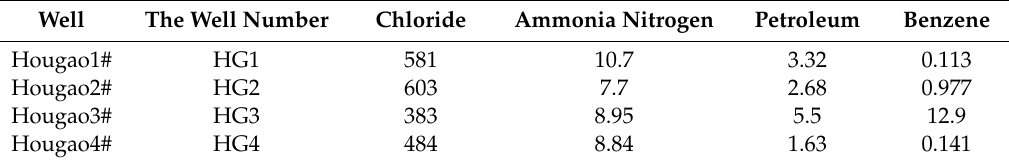
Table 1. Water quality monitoring data of Hougao’s four wells in March 2016 (mg / L). Well The Well Number Chloride